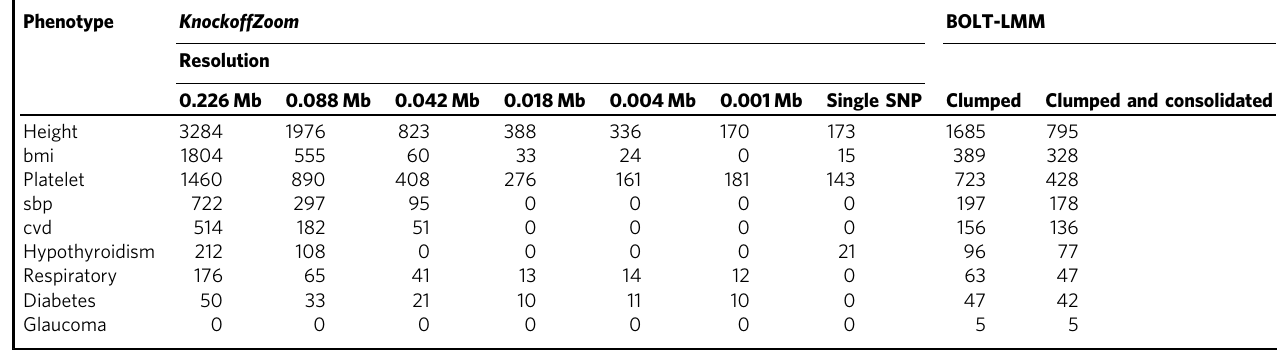
Table 1 Discoveries at different resolutions. Numbers of distinct fi ndings made by KnockoffZoom at different resolutions (FDR 0.1), on some phenotypes in the UK Biobank, compared with BOLT-LMM ( p values ≤ 5 × 10 − 8 ). Data from 350 k unrelated British individuals. The LMM discoveries are counted with two clumping heuristics, as in Fig.